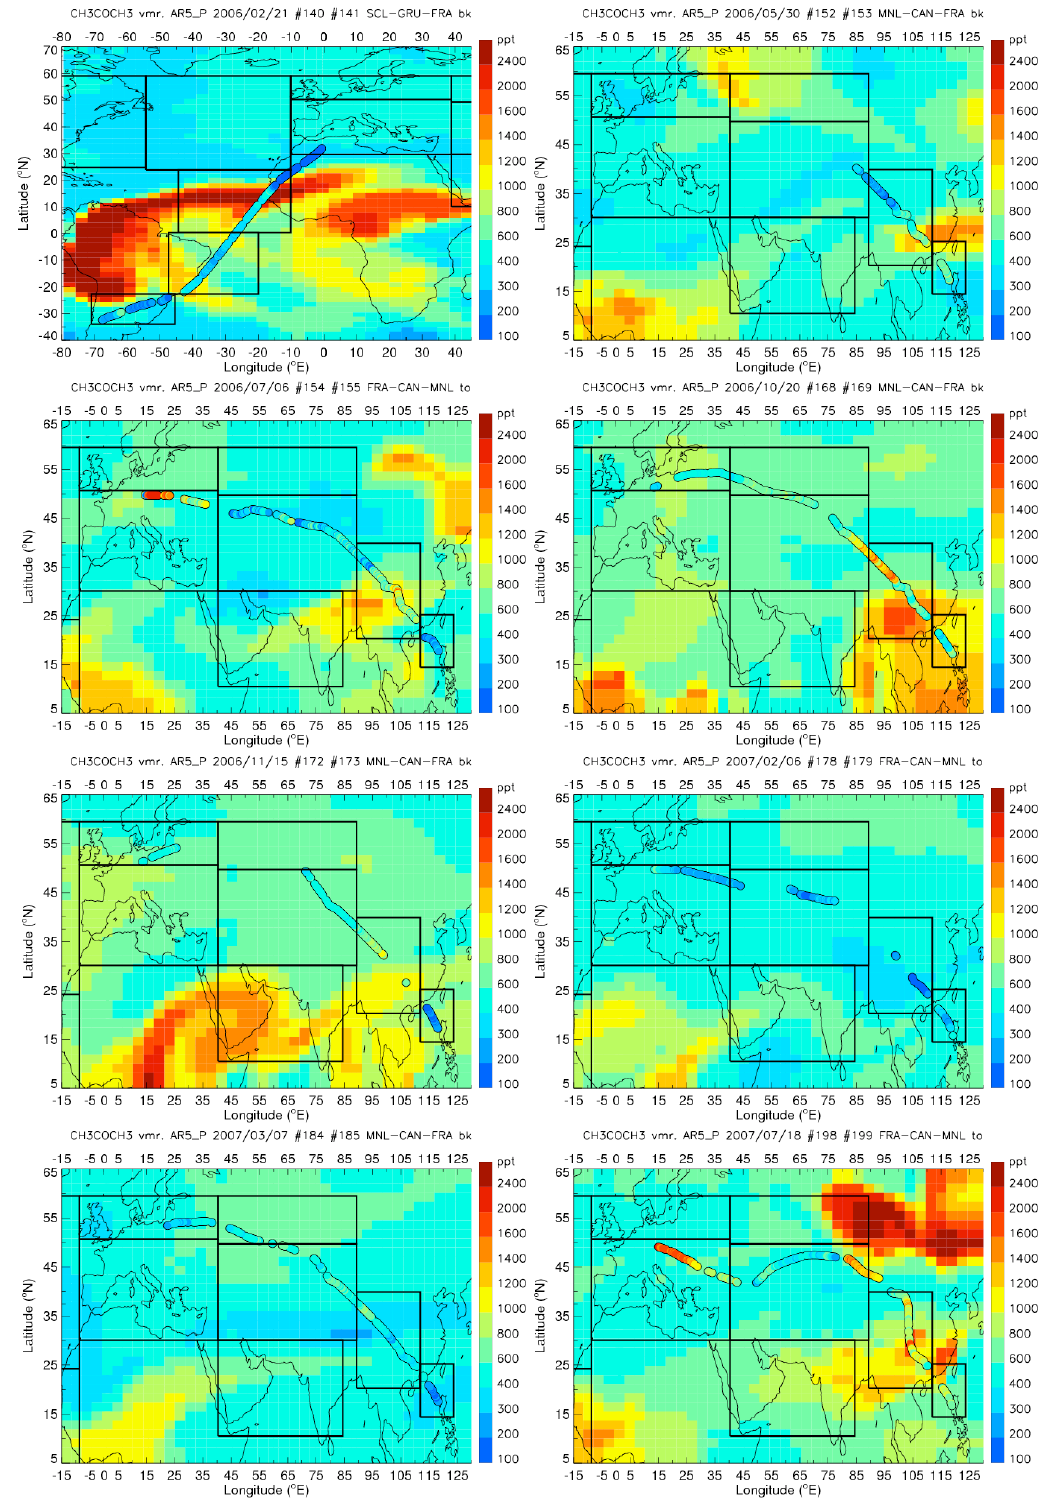
Fig. 2. Acetone vmr (pptv) along the flight track, acquired onboard the CARIBIC passenger aircraft for several flights in 2006 and 2007, superimposed on maps of daily averaged acetone vmr simulated at 238hPa by